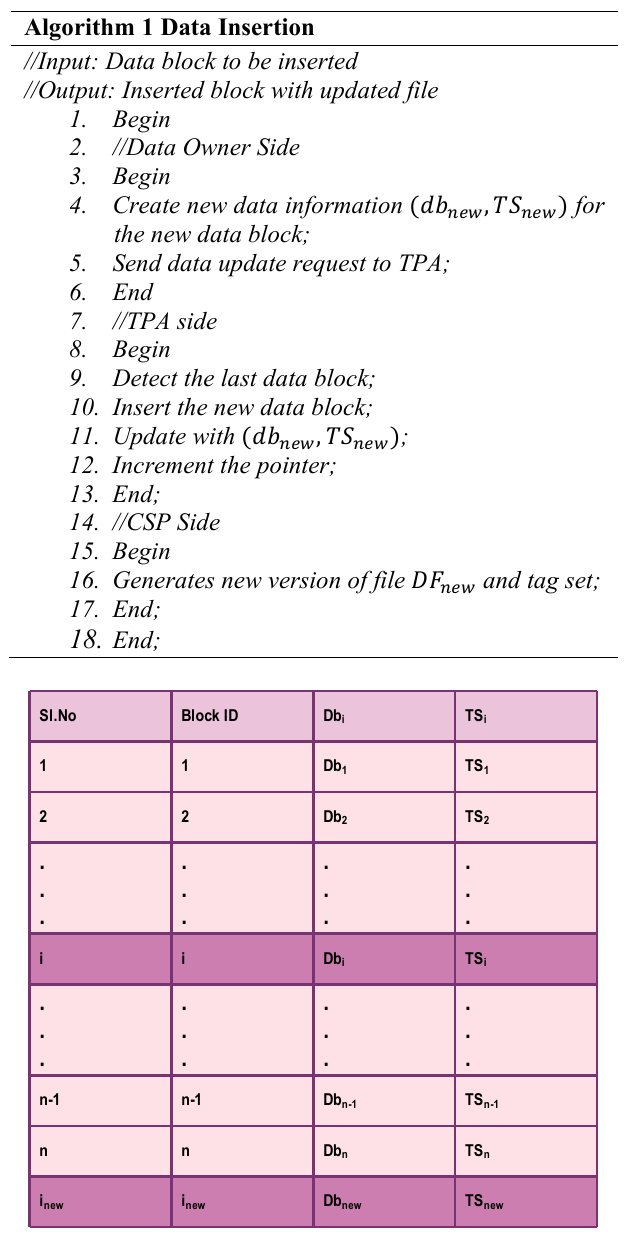
Figure 2. Data structure before performing insertion operation